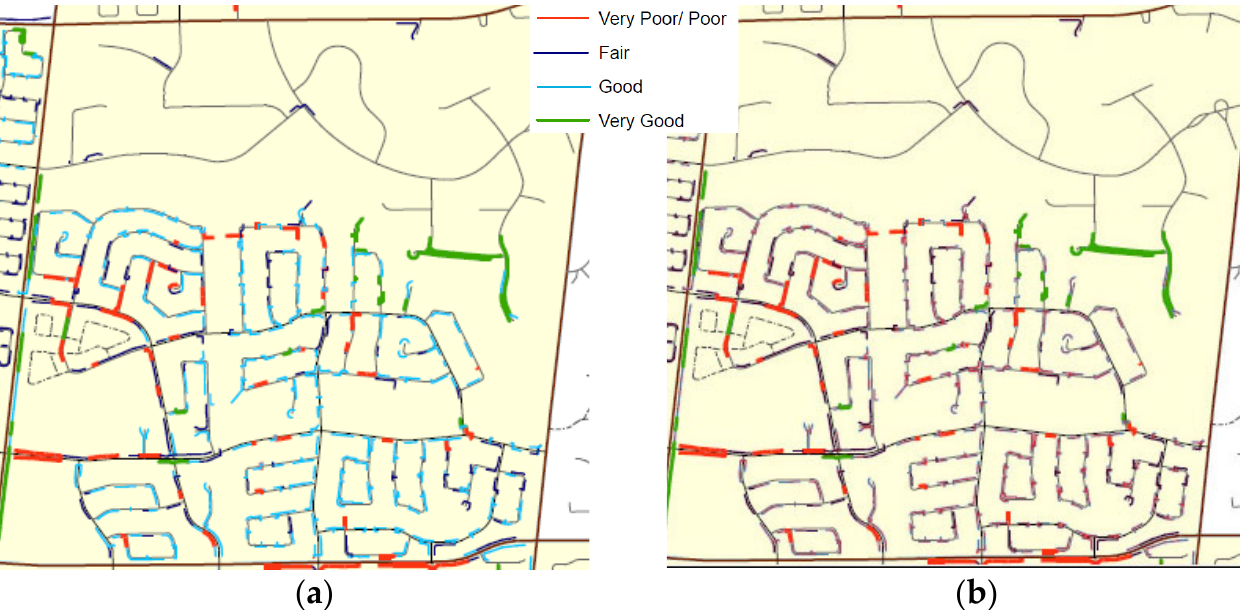
Figure 14. GIS mapping showing condition of a region of UGPCs (100 km, 28 kV, TRXLPE/XLPE, 2/0, Al, direct buried, and jacketed type) using ( a ) an age-based assessment and ( b ) a condition-based assessment through testing.